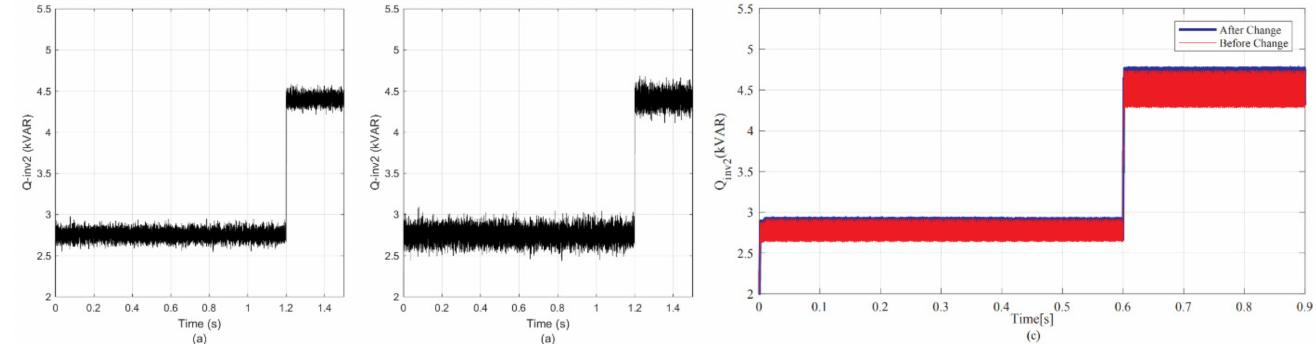
Figure 17. Reactive power of ACDG1 inverter (inv2) under two different sets of MG parameters, ( a ) under first set, ( b ) under the second set, ( c ) under two different sets of MG parameters in reference